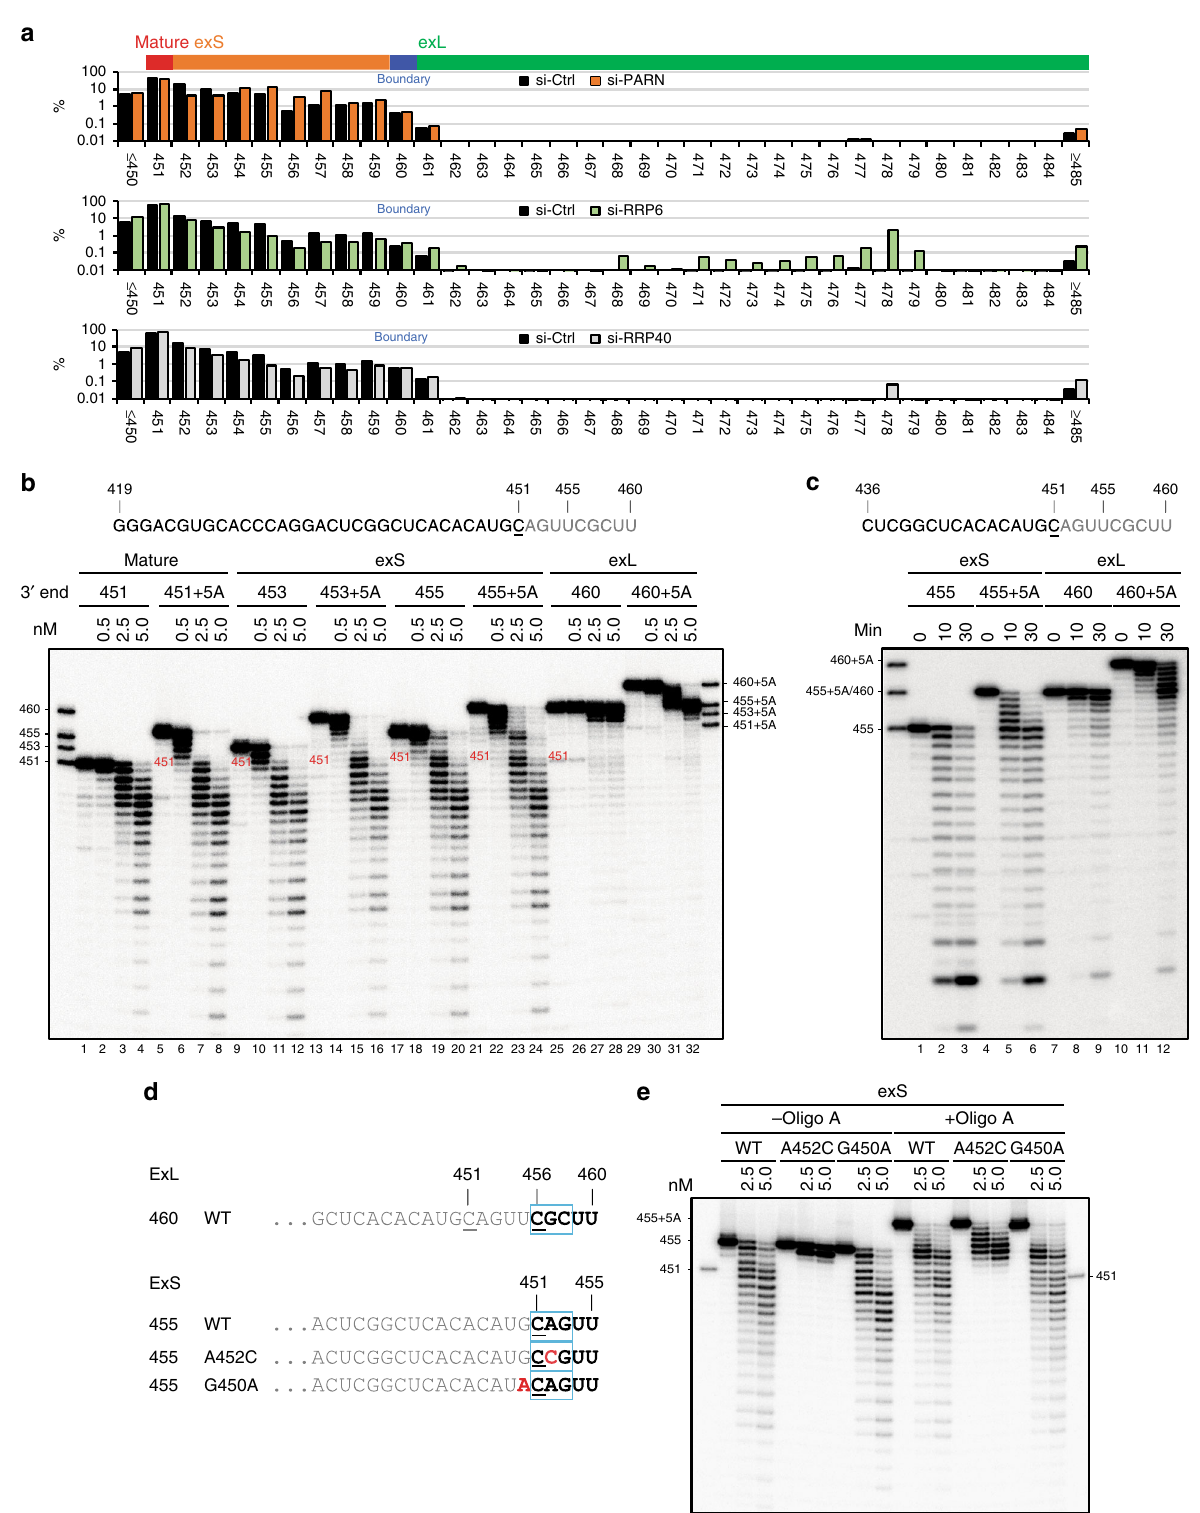
introduced A452C, A452G, and G450A mutations into exS substrates (Fig. 1d and Supplementary Figure 2b and 2c). A452C generates the sequence CCG and A452G generates CGG. In particular, A452C strongly decreased the ef fi ciency of dead- enylation and degradation by PARN, with A452G causing modest